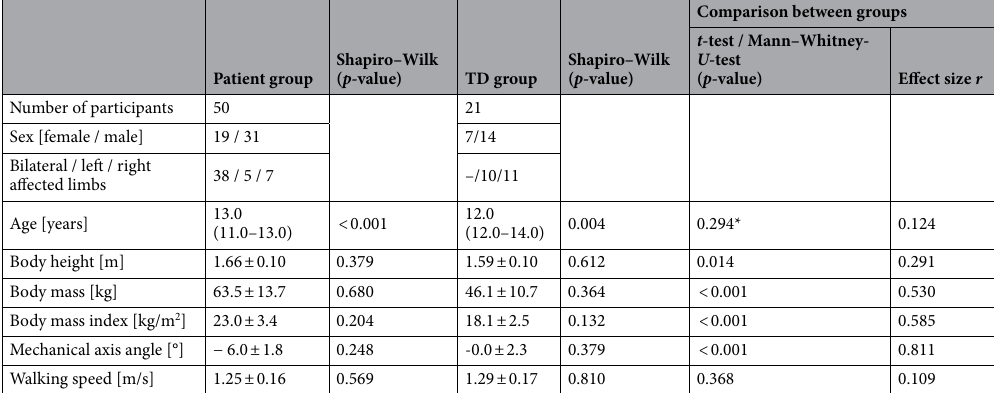
Table 1. Anthropometrics and walking speed. TD: Typically developed healthy control group; Mechanical axis angle of the patients was measured by an X-ray image; mechanical axis angle of the TD group was measured from the static trial from the three-dimensional gait analysis; Normal distributed data displayed as mean ± standard deviation; not normally distributed data are displayed as median (25. quartile—75. quartile) and marked with a *; Mann–Whitney- U -tests have been performed instead of independent t -tests for not normally distributed data; significant p -values are highlighted in bold; Effect size r > 0.1: small; r > 0.3: medium; r > 0.5: